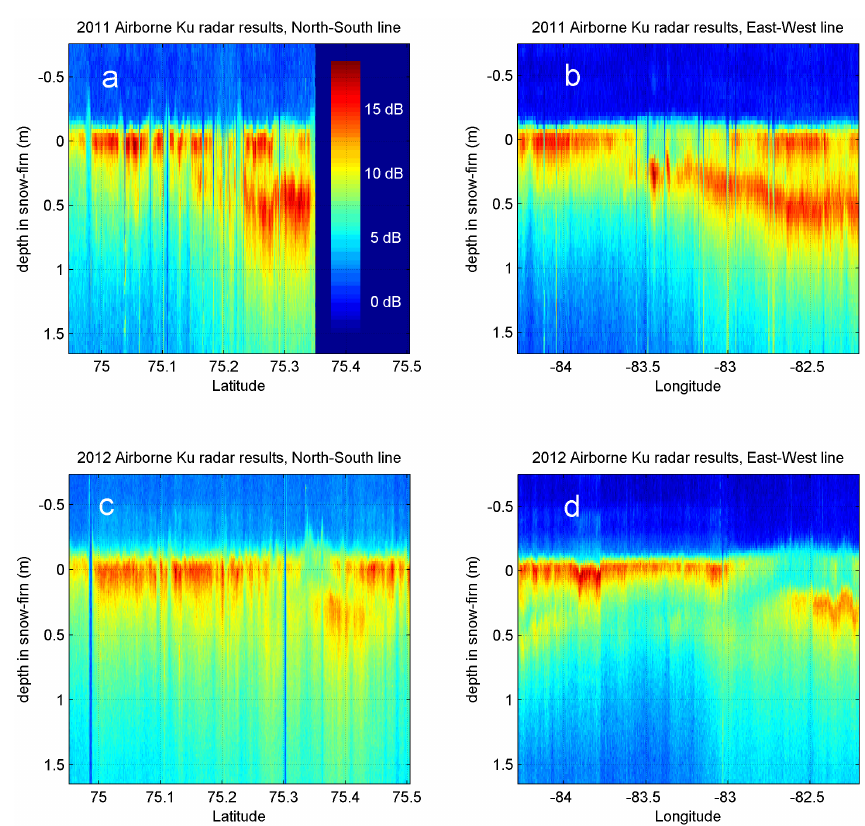
Figure 8. Variability in surface and near-surface backscatter collected over Devon Ice Cap by the CReSIS Ku band altimeter in early May in both 2011 (a, b) and 2012 (c, d) . The two left panels show the 2011 and 2012 reflected power as a function of penetration into the upper snow-firn layers and position along the north–south transect shown in Fig. 6. The two right panels show the change in return signal between the spring of 2011 and 2012 for the east–west line. A sub-surface propagation speed of 0.225mns − 1 was assumed in preparing this